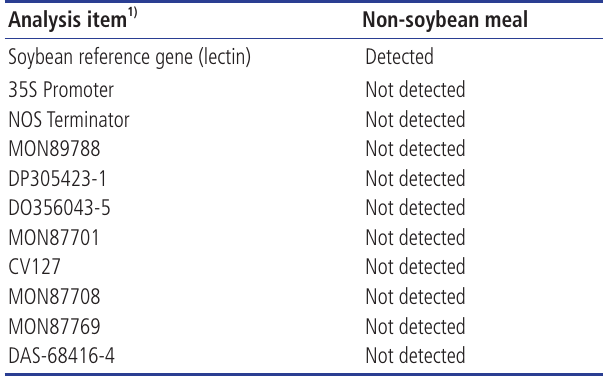
Table 2. Qualitative analysis of genetically modified soybean meal Analysis item